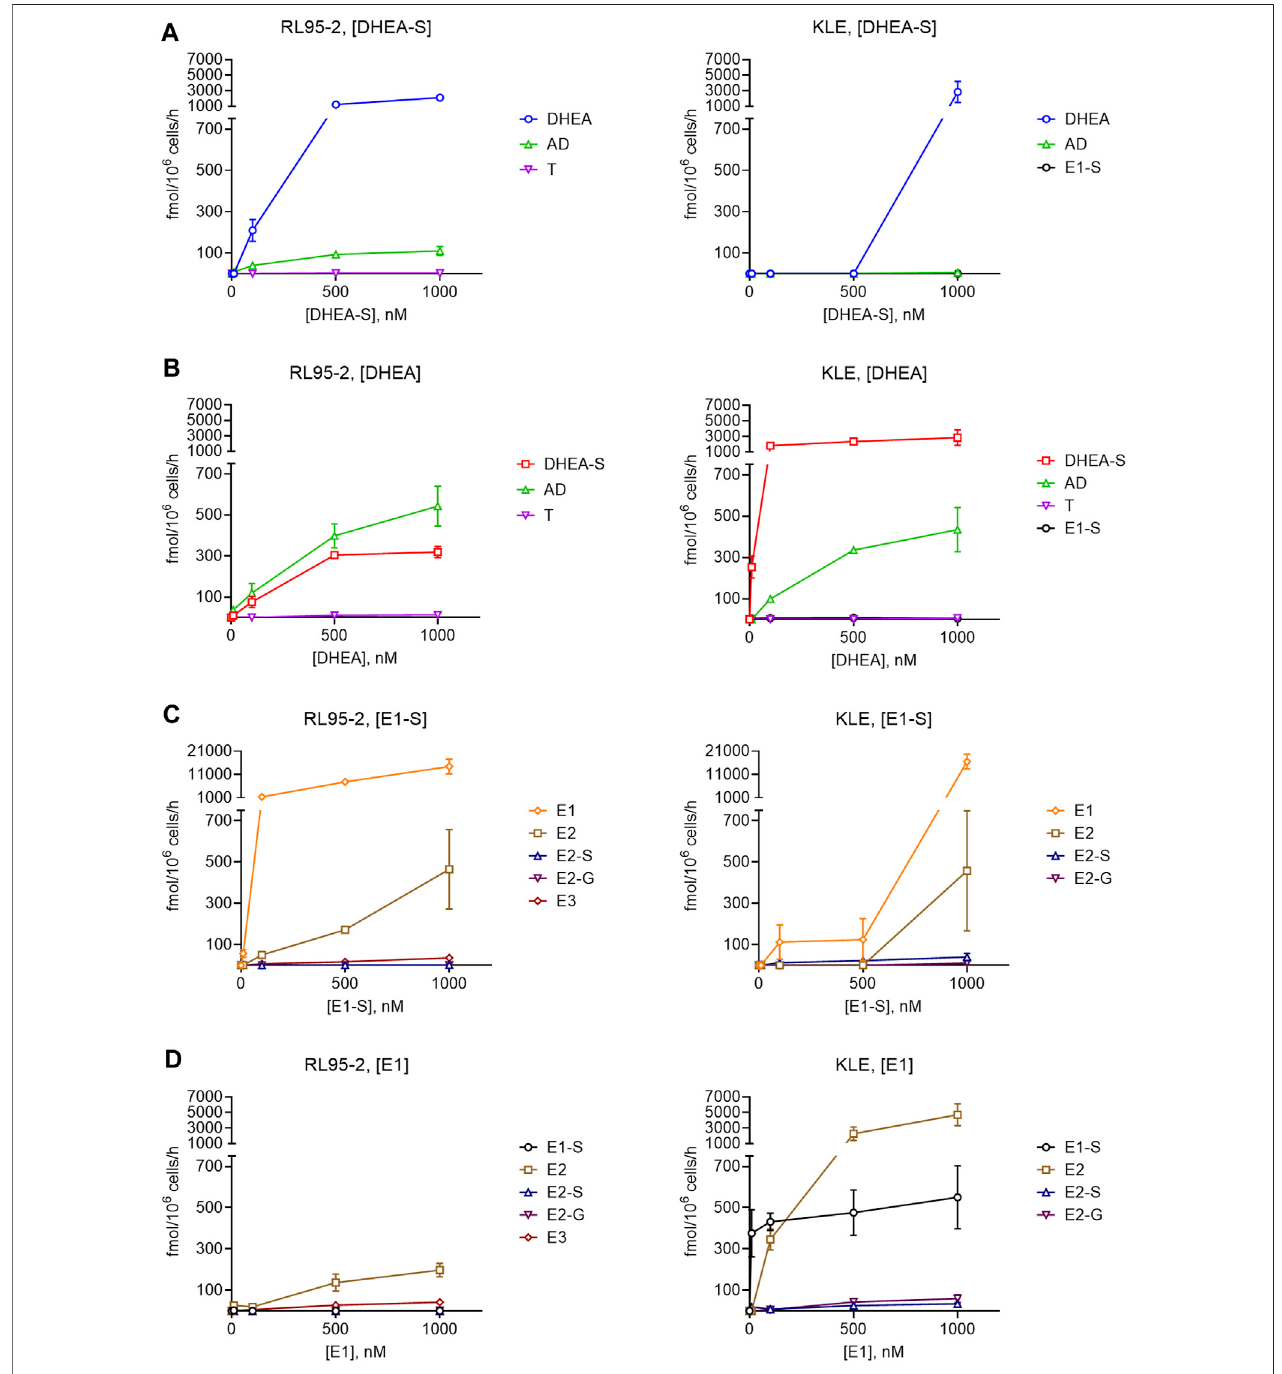
FIGURE 5 | Metabolism of DHEA-S (A) , DHEA (B) , E1-S (C) and E1 (D) in RL95-2 (left) and KLE (right) cells. Metabolites were separated and quanti fi ed by LC- HRMS. AD, androstenedione; E2-G, E2-glucuronide; E3, estriol; T, testosterone; for other abbreviations see main text.